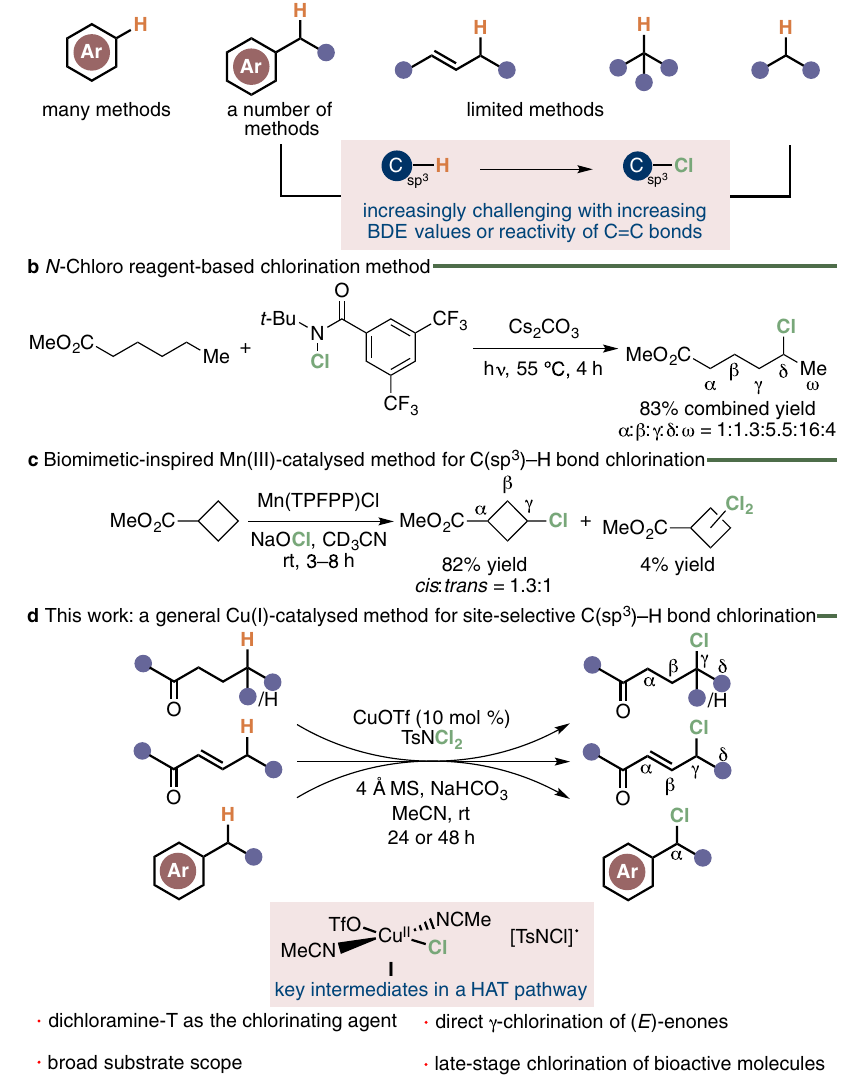
Fig. 1 Synthetic strategies for intermolecular site-selective C – H bond chlorination. a A comparison of the number of synthetic methods for site-selective aromatic, benzylic, allylic and alkyl chlorination. b Example of site-selective aliphatic chlorination by N -chloro-based reagents. c Example of site-selective aliphatic chlorination by directing group-assisted transition metal catalysis. TPFPP = 5,10,15,20-tetrakis(penta fl uorophenyl)porphyrinate. d Cu(I)-catalysed site-selective C( sp 3 ) – H bond chlorination of ketones, ( E )-enones and alkylbenzenes by